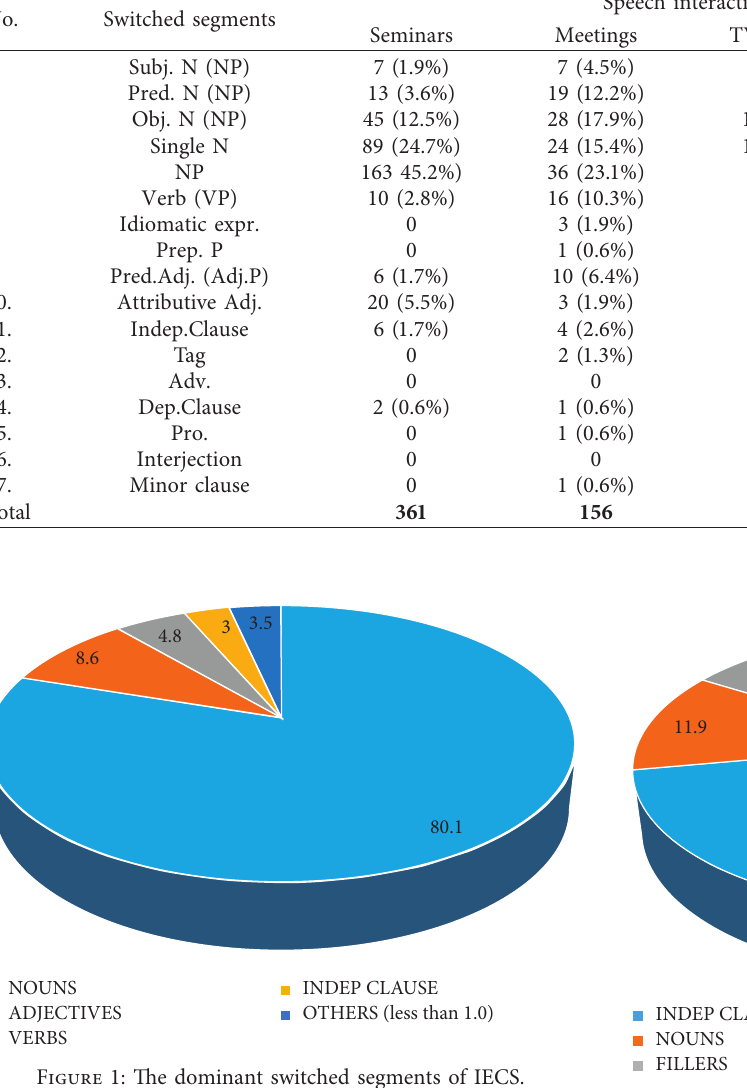
Figure 2: The dominant switched segments of